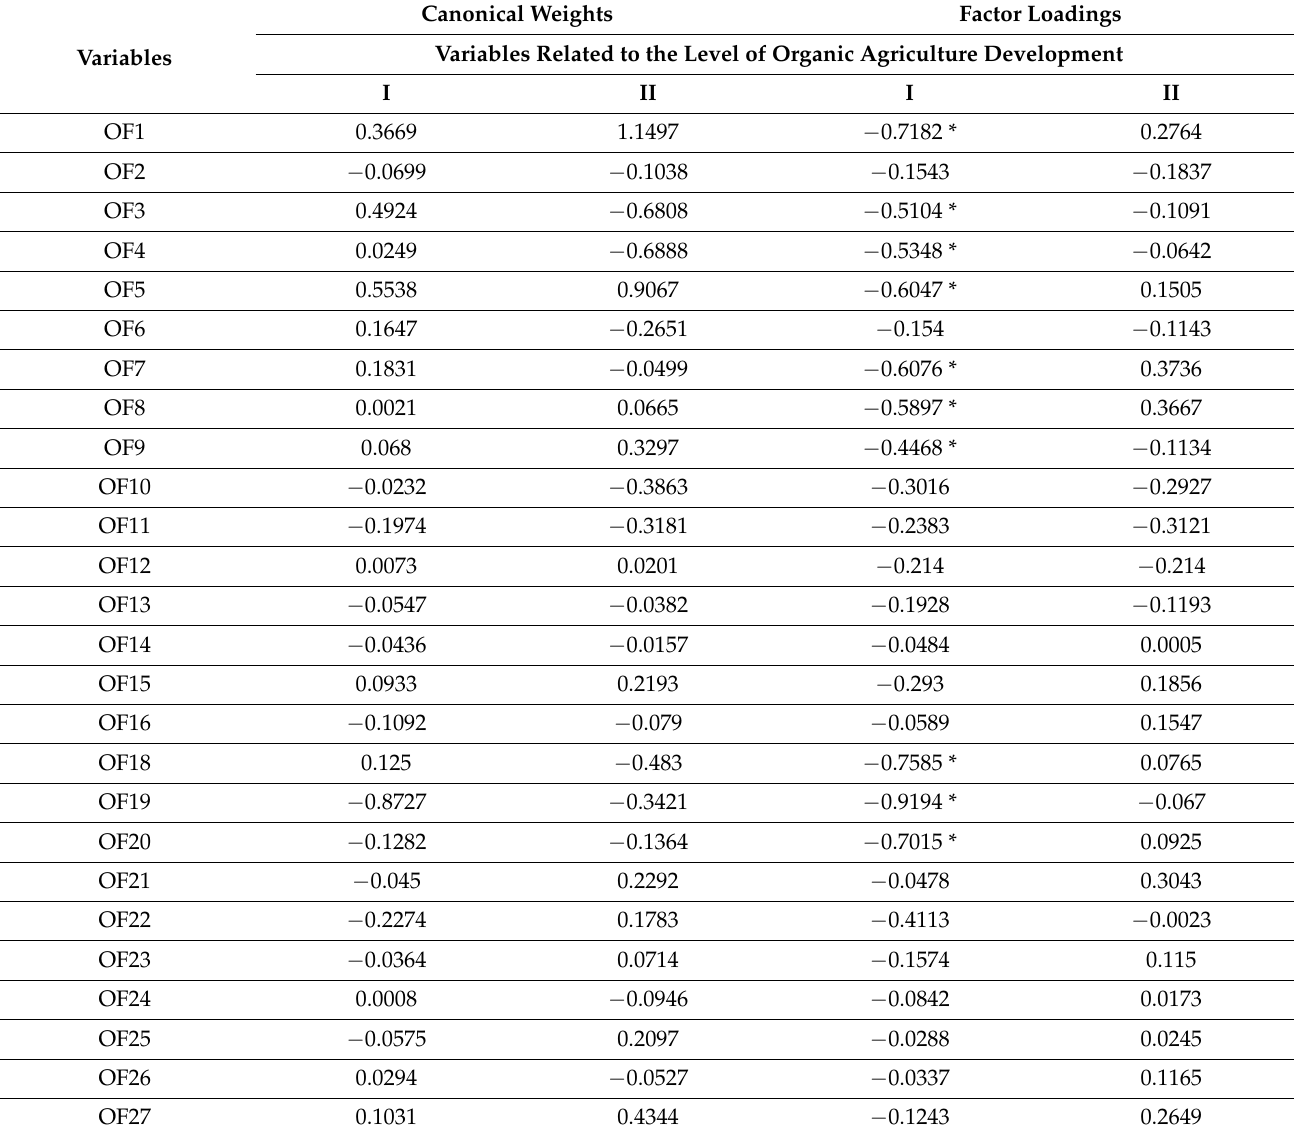
Table 5. Canonical weights and factor